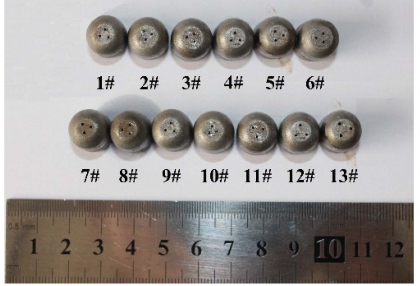
Figure 5. Self-propelled nozzles with different forward